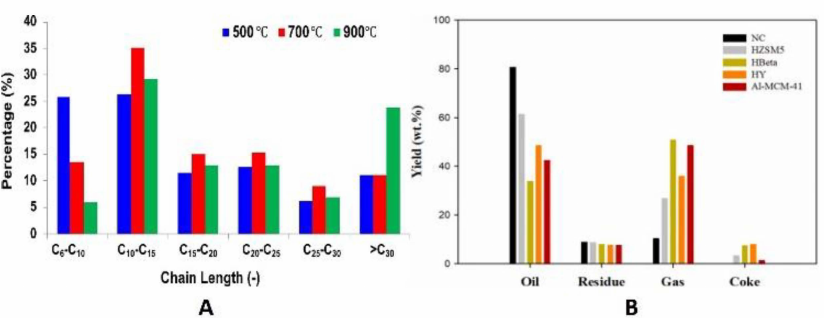
Figure 4. ( A ) Percentages of different ranges of carbon chain lengths from disposable mask pyrolysis. Reproduced with permission from Ref. [41]. Copyright 2021 The Authors. Published by Wiley-VCH GmbH. ( B ) Product distributions of catalytic (HZSM5, HBeta, HY and Al-MCM-41) and non-catalytic (represented by NC in the figure) pyrolysis of disposable masks. Reproduced with permission from Ref. [64]. Copyright 2021 Elsevier Ltd.